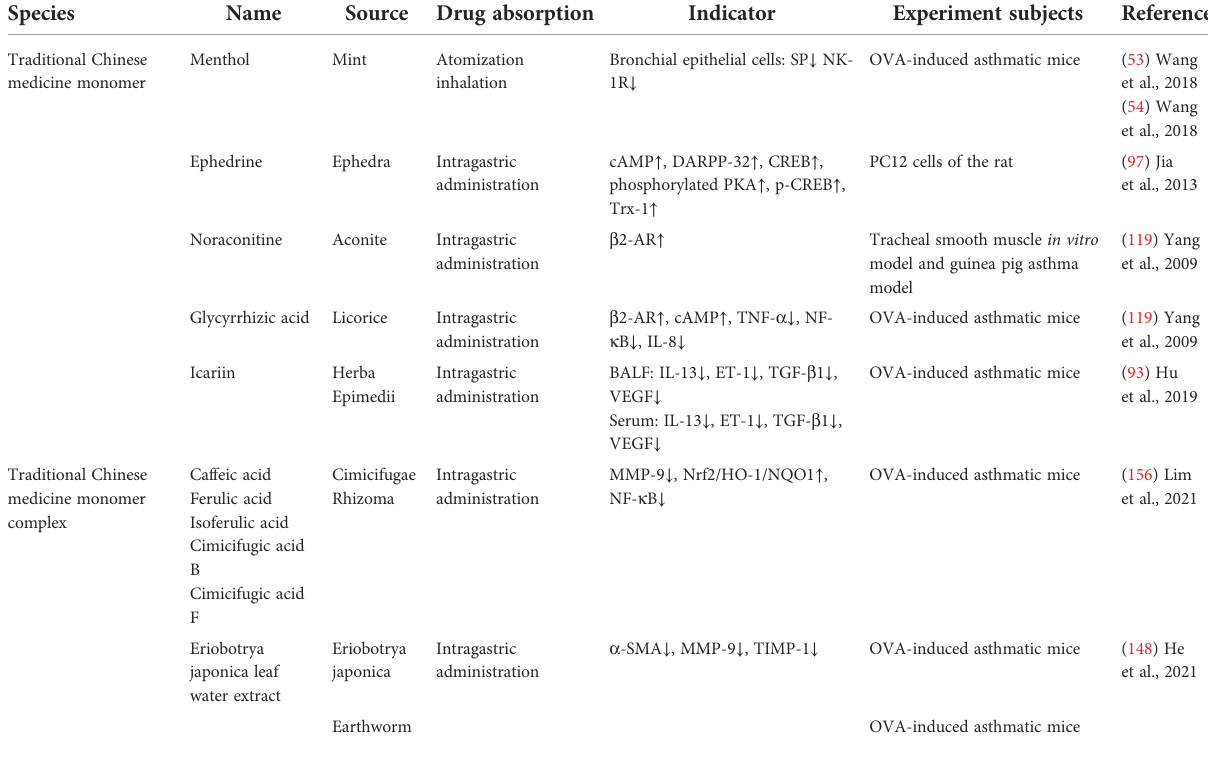
TABLE 3 The mechanism of traditional Chinese medicine monomer, traditional Chinese medicine monomer complex, and single herbs in the treatment of asthma.